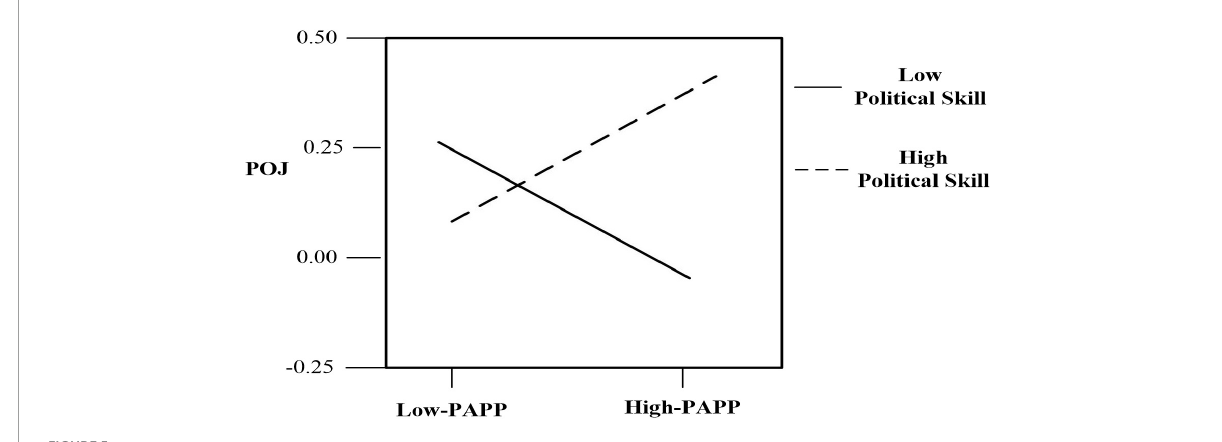
FIGURE5 The Moderating effect of political skill on the relationship between PAPP and